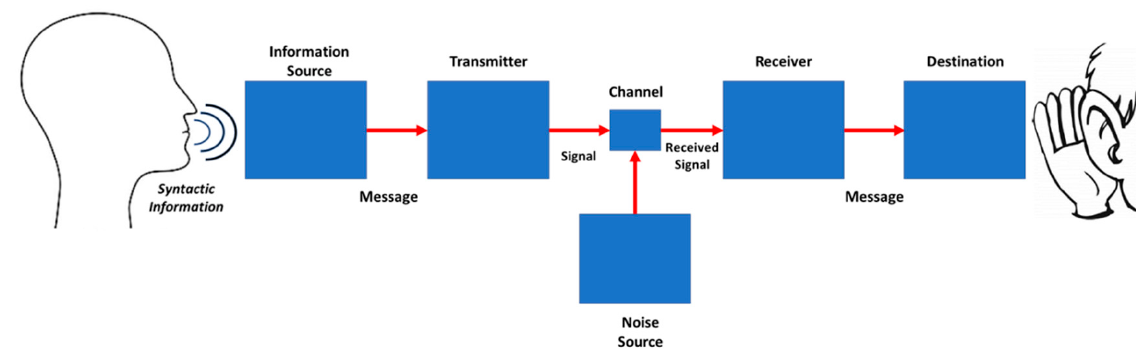
Figure 1. The communication process (adapted from [27]).